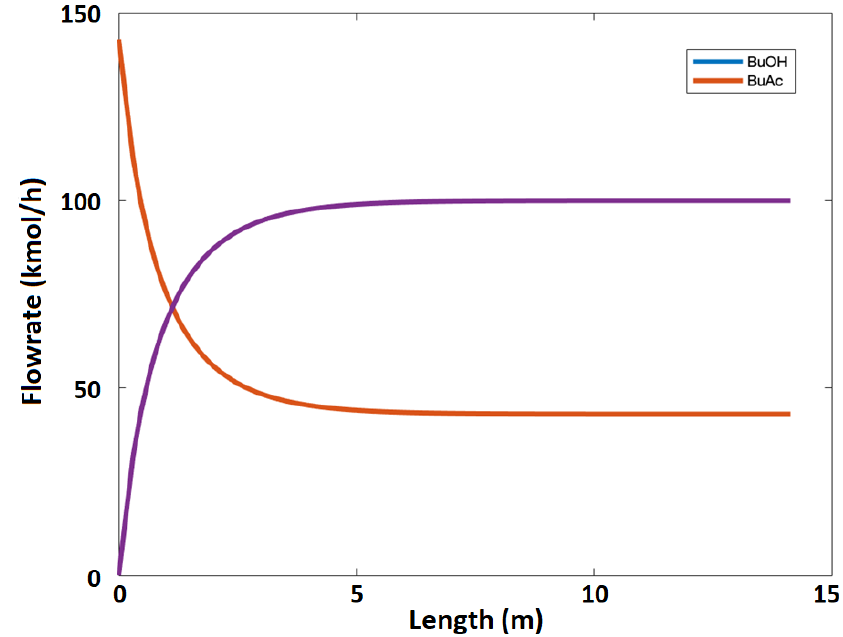
Figure 12. Components flowrates as a function of reactor length using the kinetic model.